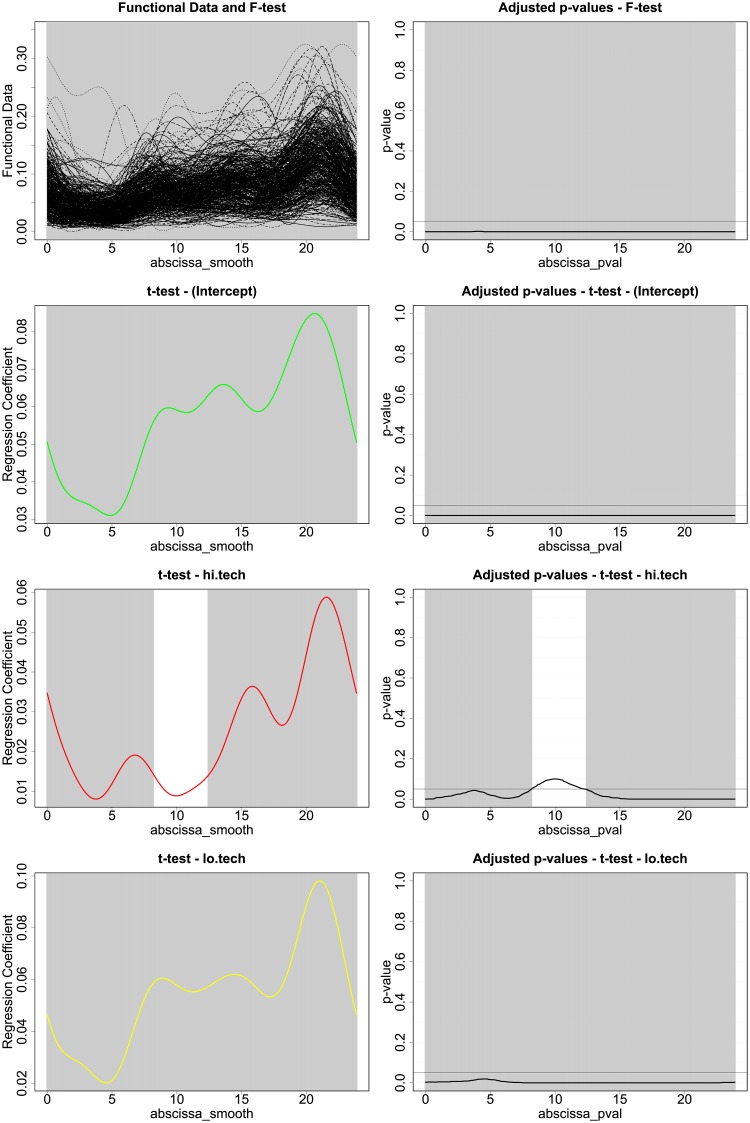
F-Test and t-Tests for regression model in Eq 3.